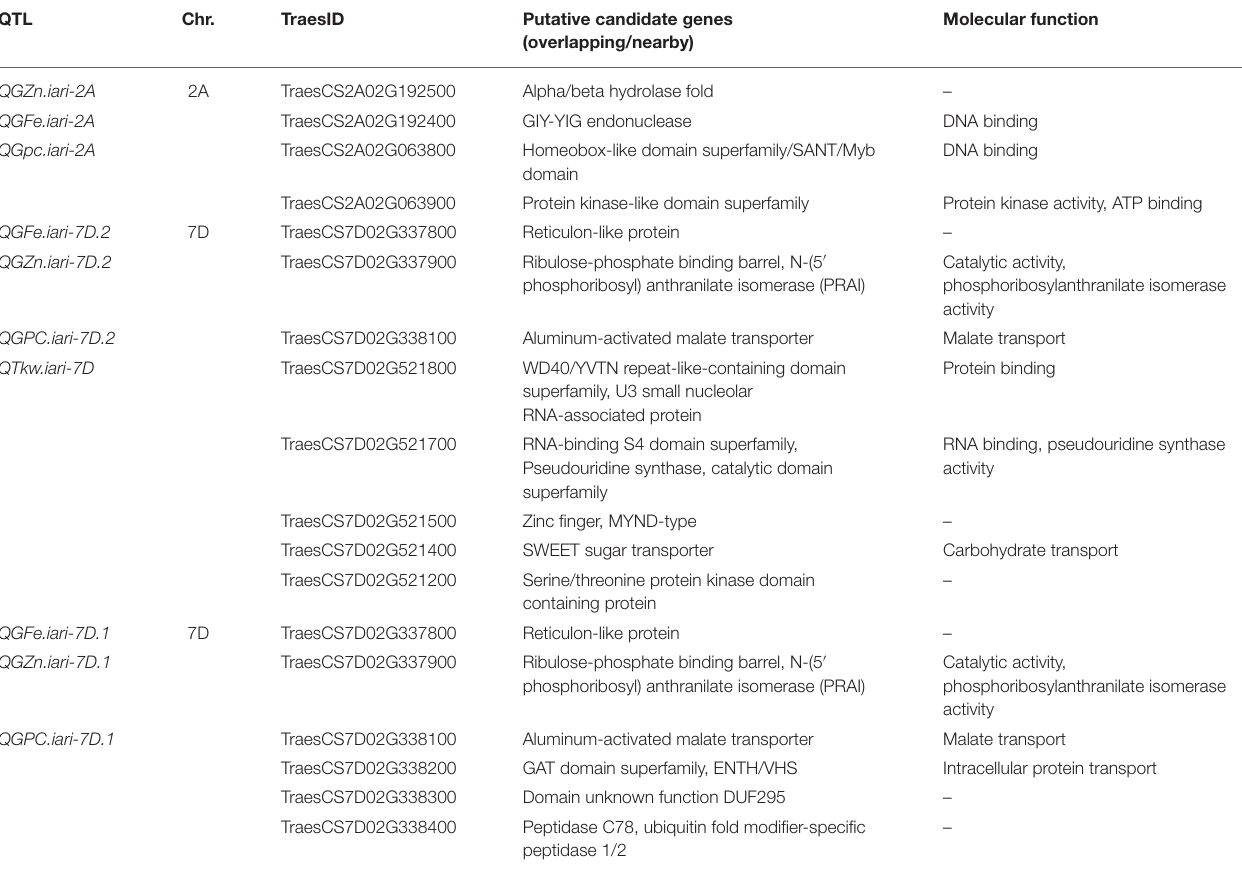
TABLE 6 | Putative candidate genes for grain iron (GFeC), zinc (GZnC), protein (GPC), and thousand kernel weight in the RIL population.